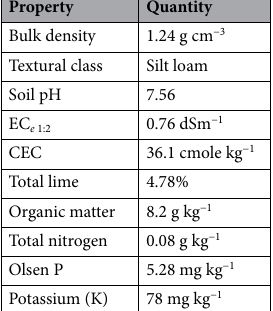
Table 7. Physico-chemical properties of soil used in experiment before